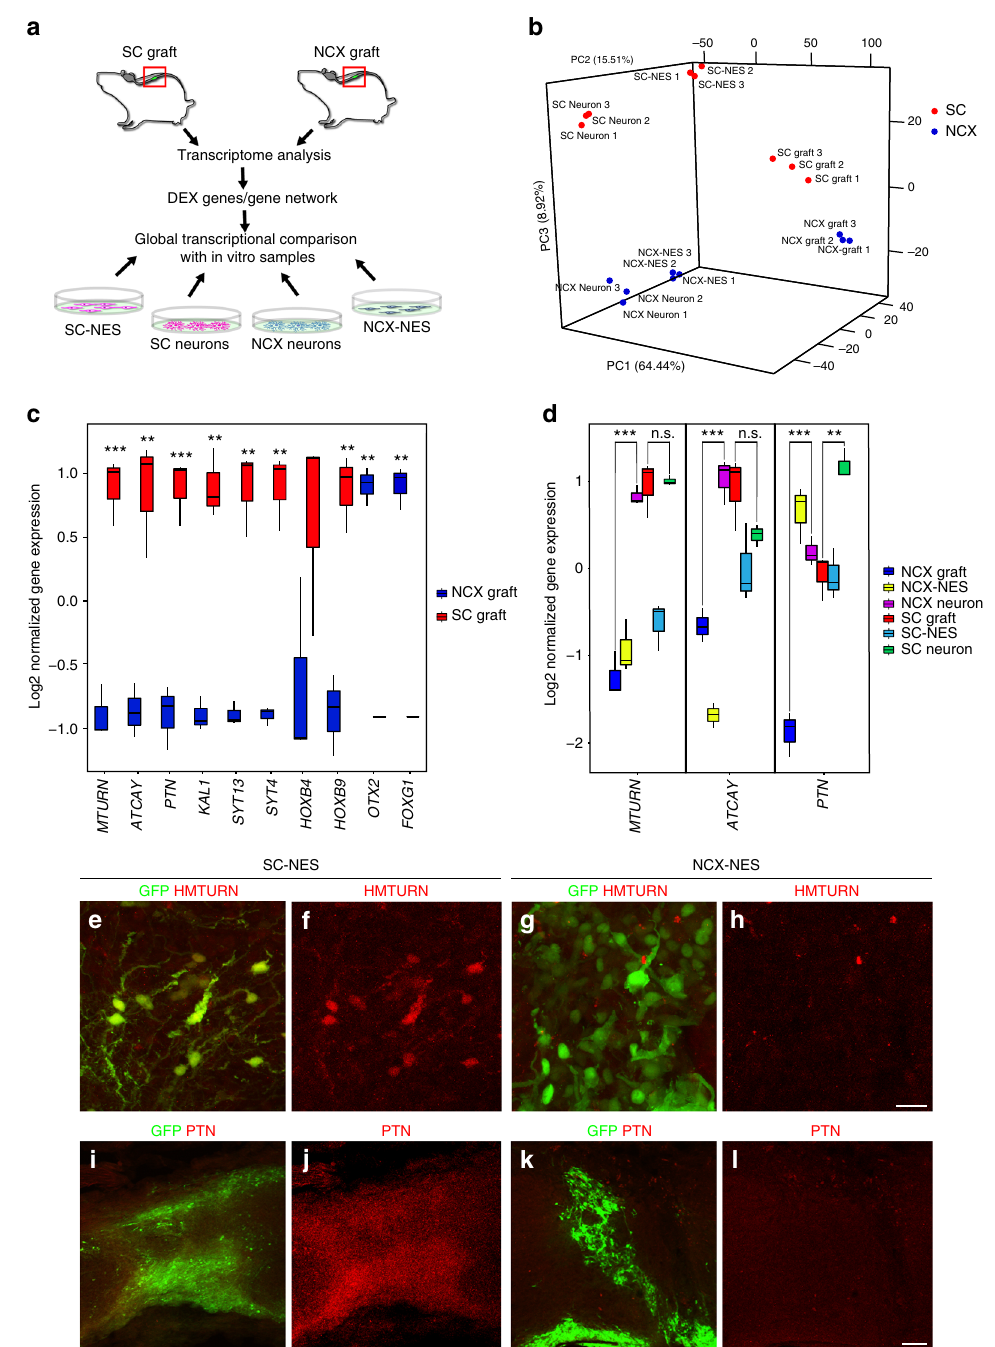
Fig. 7 Global transcriptome analysis reveals SC-NES cell neuronal commitment after transplantation. a Schematics of the experimental procedure. SC- and NCX-NES cell grafts were isolated from recipient mice 8 weeks after implantation. RNA-seq was performed to identify differentially expressed (DEX) genes in the two samples. The expression level of DEX genes was eventually compared with in vitro samples: proliferating cells from both SC and NCX (SC-NES; NCX-NES), and cells upon 8 weeks of differentiation (SC Neurons; NCX Neurons). b 3D plot of the principal component analysis (PCA) of SC- and NCX- NES cells in proliferation (NES), after in vitro differentiation (neuron) or in vivo transplant for 8 weeks (graft). Each dot represents a sample. c Box plot of normalized gene expression for selected genes in SC- and NCX-NES cell grafts. The black bar within each box represents the median value. Vertical bars indicate the maximum and minimum values. d Box plot of normalized gene expression of maturin ( MTURN ), caytaxin ( ATCAY ) and pleiotrophin ( PTN ) genes across all SC ad NCX samples. The black bar within each box represents the median value. Vertical bars indicate the maximum and minimum value. e – h Human MTURN (HMTURN) and GFP stainings of SC- and NCX-NES cells 8 weeks after engraftment. Samples derived from the SC express HMTURN after grafting, whereas grafted NCX cells are HMTURN-negative. i – l Human PTN (PTN) and GFP stainings con fi rming the expression of PTN in grafted SC- NES cells and its absence in grafted NCX-NES cells. Scale bars: e – h 20 µ m; i – l 50 µ m. (** P < 0.01, *** P < 0.001; Student ’ s t